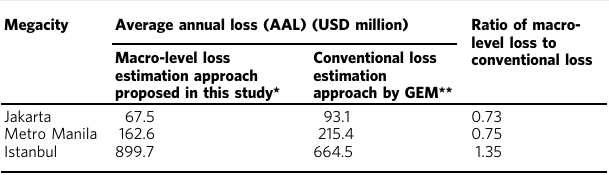
Table 2 Comparison of present megacity-level AAL values obtained by our macro-level approach and GEM ’ s conventional